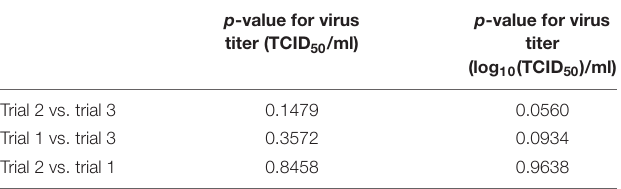
TABLE 8 | Tukey’s test on the statistical significance of the three trials. p -value for virus p -value for virus titer (TCID 50 /ml) titer (log 10 (TCID 50 )/ml) Trial 2 vs. trial 3 0.1479 0.0560 0.0934 0.8458